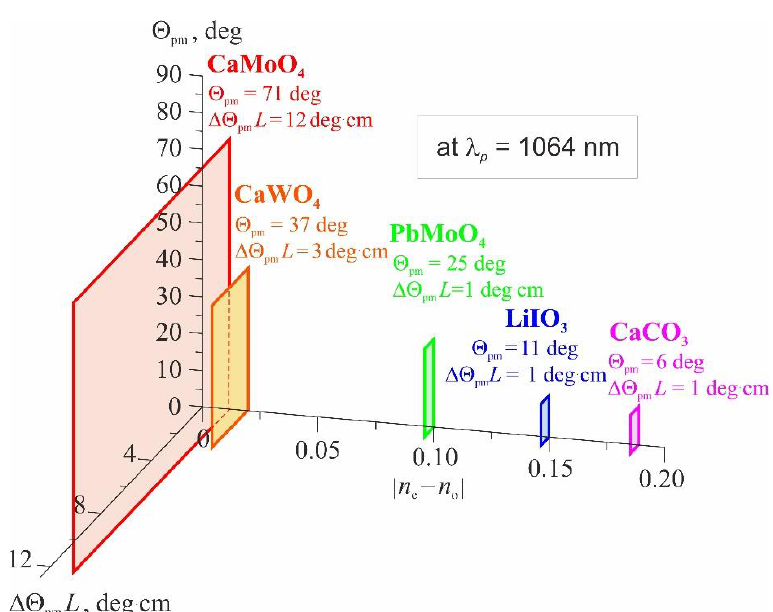
Figure 1. Overview diagram of the phase-matching characteristics ( Θ pm and ∆Θ pm ) of parametric Raman anti-Stokes generation under pumping at λ p = 1064 nm for known uniaxial Raman-active crystals depending on their birefringence.